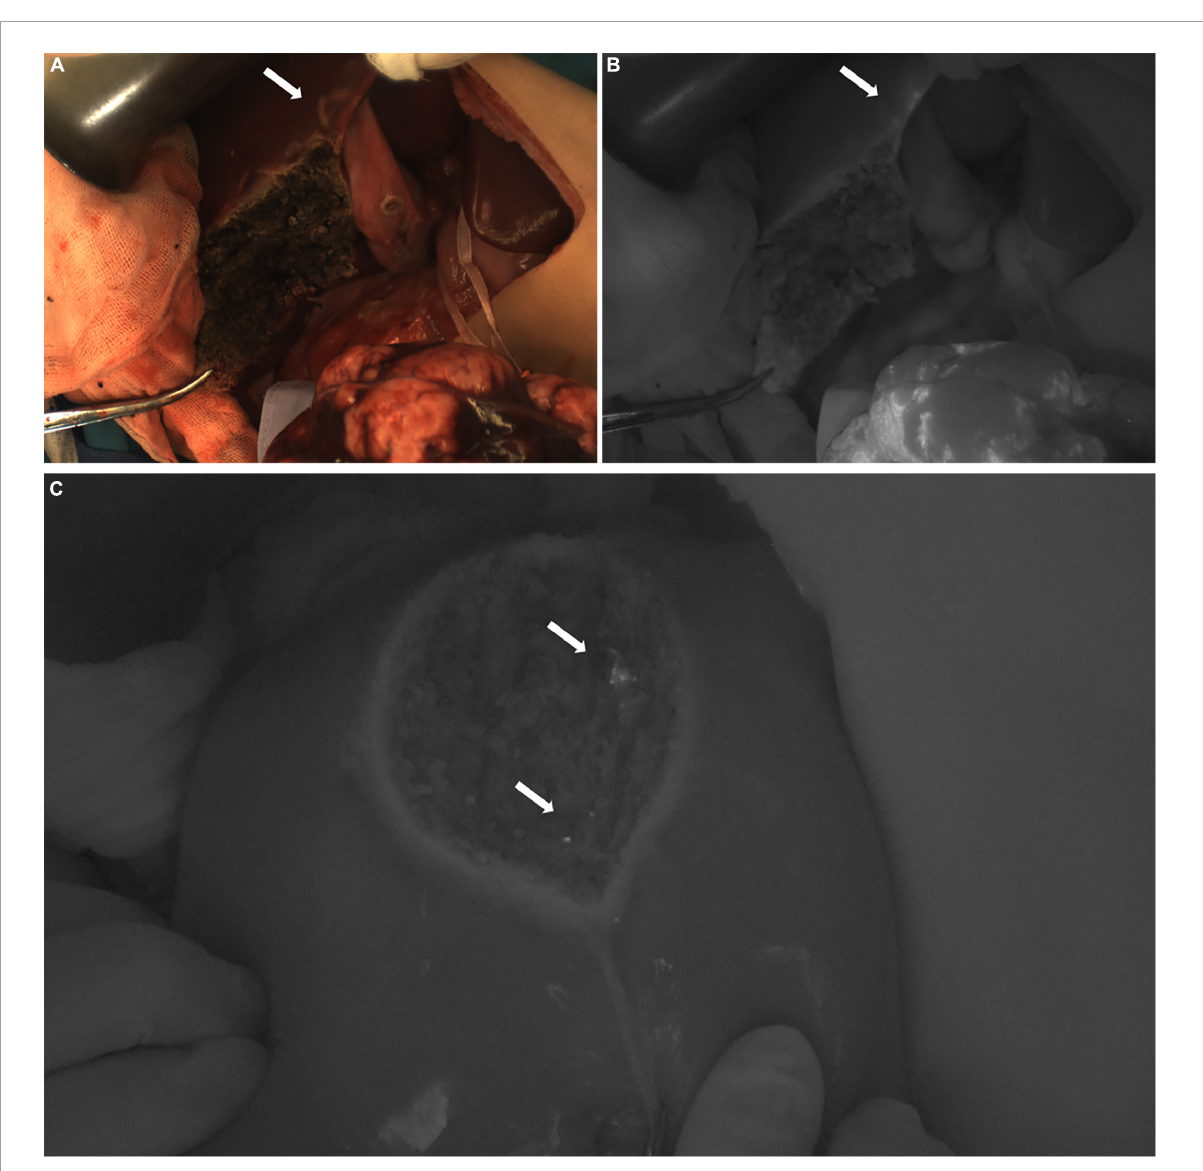
FIGURE7 (A,B) Case 5. The white light and fluorescence images of the residual liver during the operation, with the white arrow pointing to the ICG (+) lesion away from the tumor 3 cm. (C) Case 8. The fluorescence image of the resection stump of the residual liver tissue, with white arrows pointing to two ICG (+) regions,